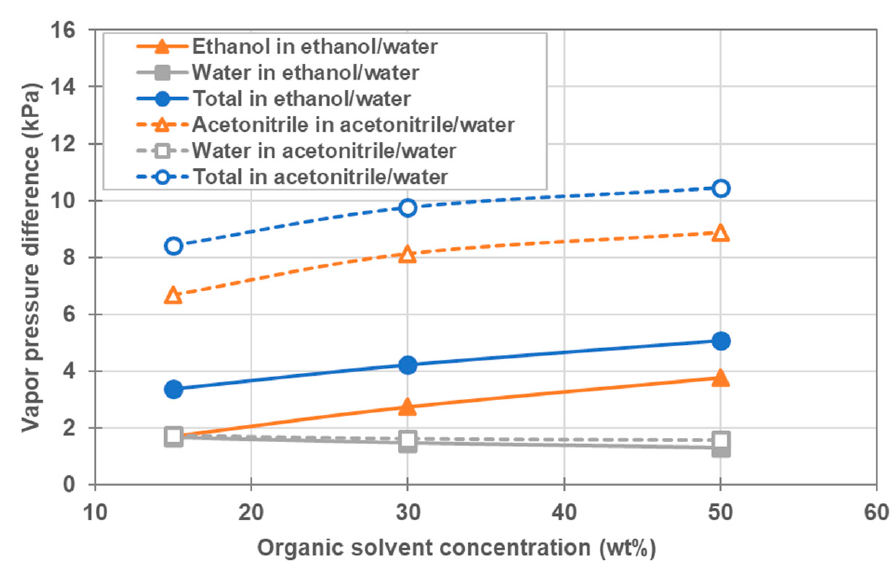
Figure 10. Vapor pressure differences between feed side and permeate side of ethanol/water and acetonitrile/water systems in the beginning of operation under the condition shown in Table 7. Open and closed symbols show the vapor pressure difference of acetonitrile/water mixture, and ethanol/water mixture, respectively. Triangles show the partial vapor pressure difference of organic solvent, squares the partial vapor pressure difference of water and circles the total vapor pressure dif- ference.